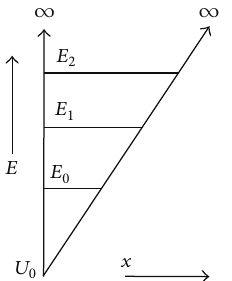
Figure 1: The energy spectrum of an infinite triangular potential